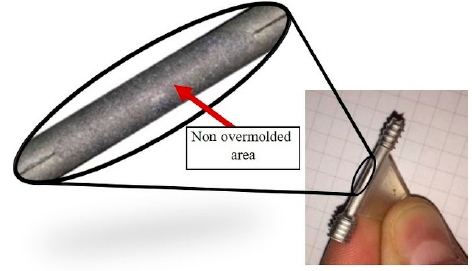
Figure 18. Screw showing non-overmolded area.